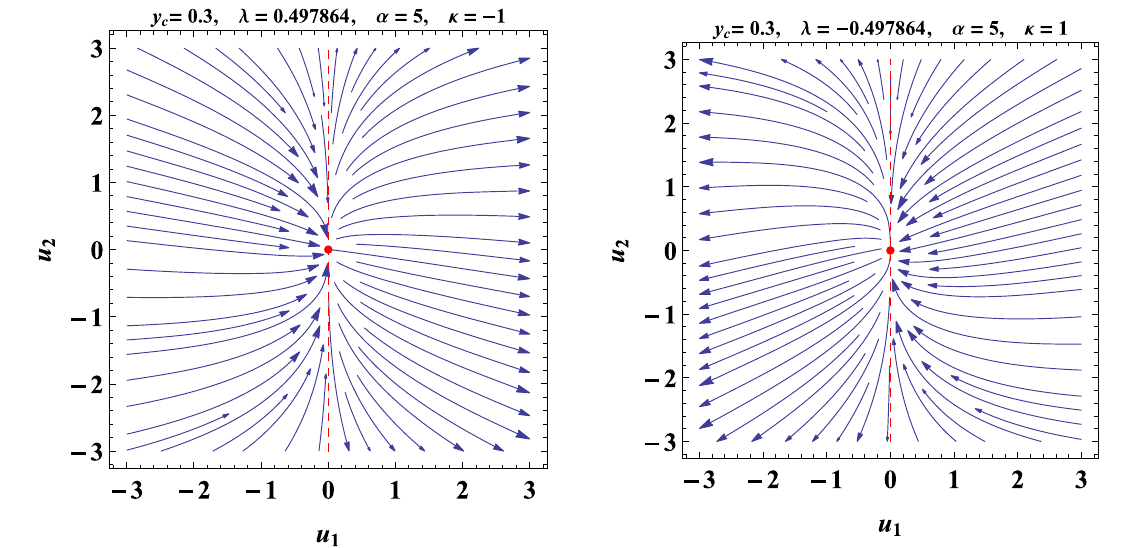
Fig. 3 Phase plot of system (46) for some values of the parameters showing that A (cid:4)